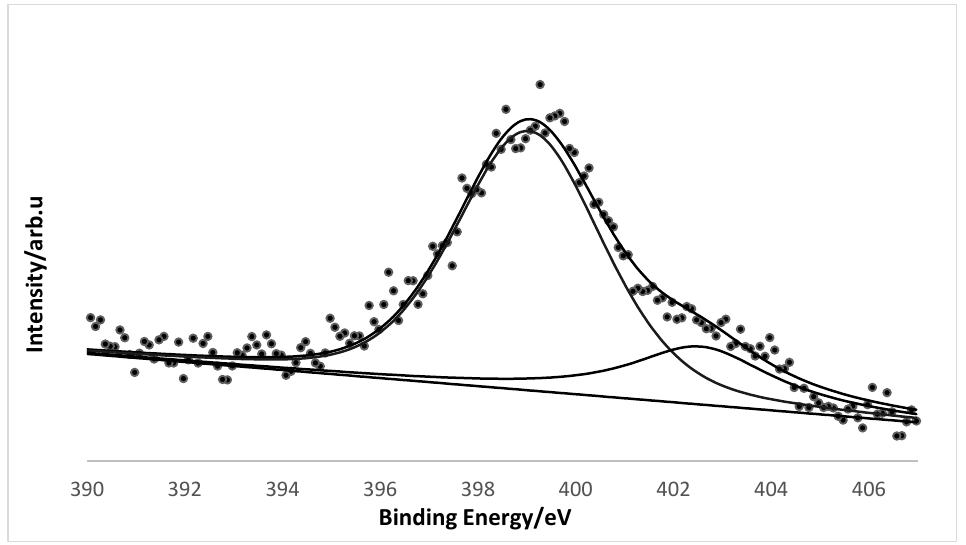
Figure 3. N 1s peak of the metalloporphyrin functionalized DNs.